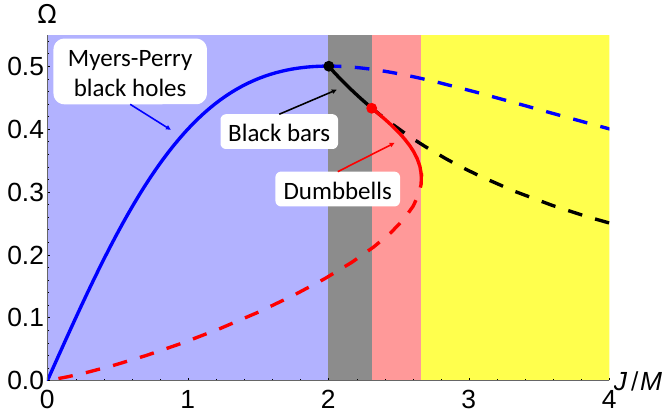
Figure 3 . Phases of blobs and their stability as relevant to outcomes of mergers. Solid/dashed lines are stable/unstable stationary blobs. Blue: Myers-Perry black holes, stable up to J=M = 2. p Black: black bars, stable up to J=M = 4 = 3 (cid:25) 2 : 31. Red: black dumbbells, stable up to J=M = ( J=M ) c (cid:25) 2 : 66 (dumbbells along the dashed line are unstable binaries of blobs). The background shading indicates the expected outcome of a merger for an initial value of J=M . No stable stationary blobs exist for J=M > ( J=M ) c (yellow), so, if a merger occurs in this region, it can only evolve to a multi-blob state. The numerical solutions for dumbbells are from [31]. The same color coding is used in the next